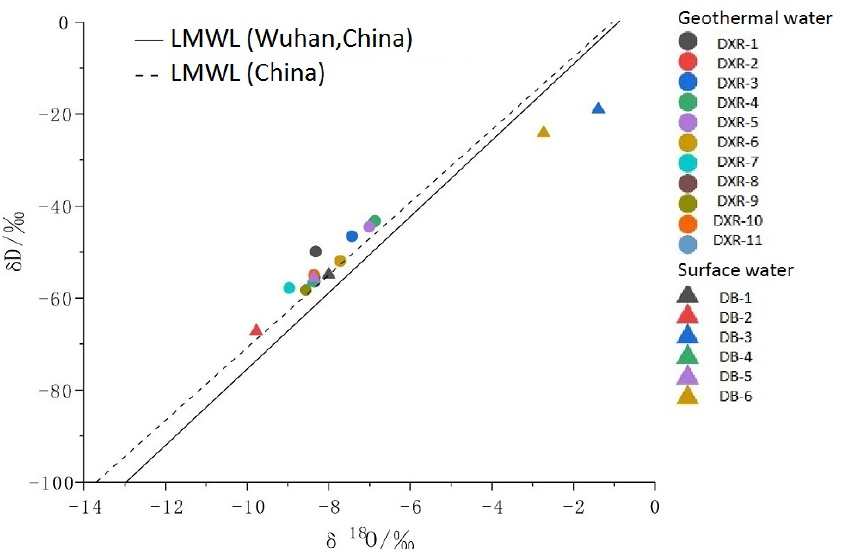
Figure 3. Distribution map of deuterium oxygen isotopes in surface and underground hot water.